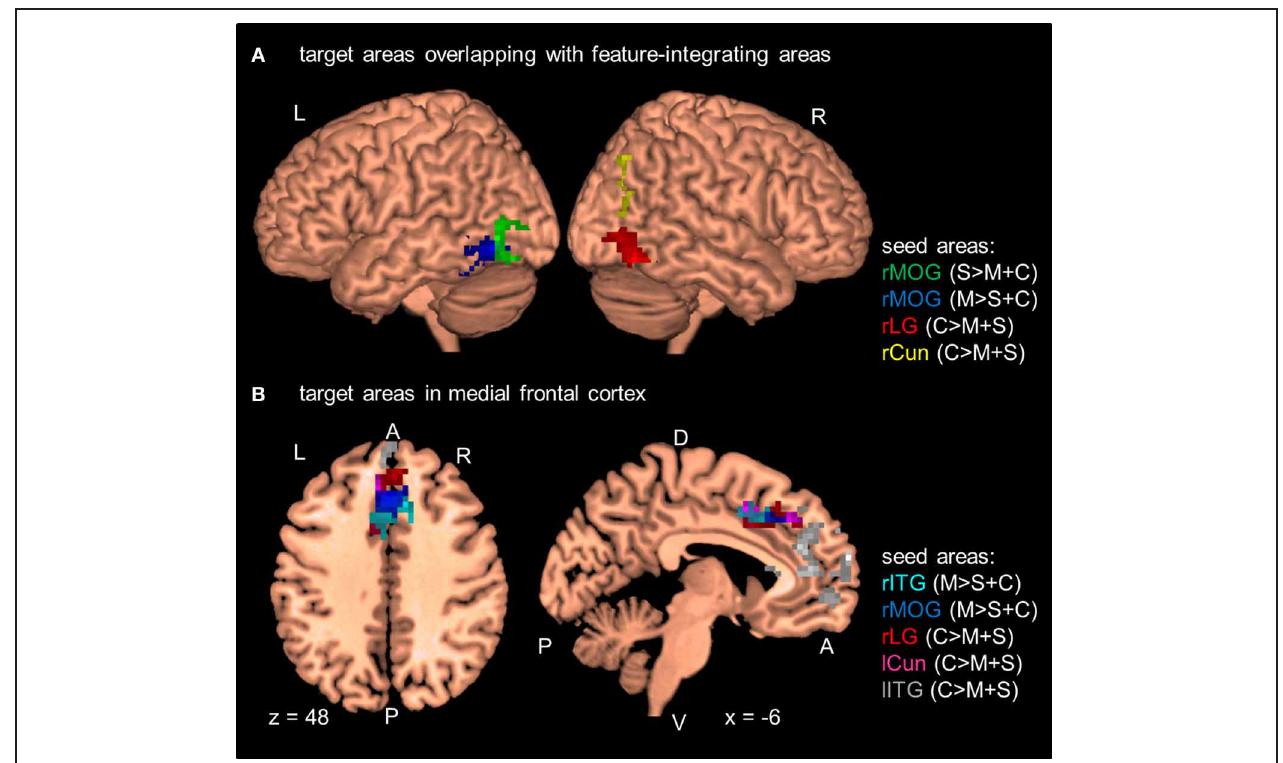
rITG, right inferior temporal gyrus; rCun, right cuneus; rMOG, right middle occipital gyrus; rLG, right lingual gyrus; lITG, left inferior temporal gyrus; lCun, left cuneus. For clarity only a selection of target areas are shown (see Table 5 ). (A) Target areas that overlapped with MT and LOC as localized by our MT- and LOC-localizer. (B) Target areas that cluster in medial frontal